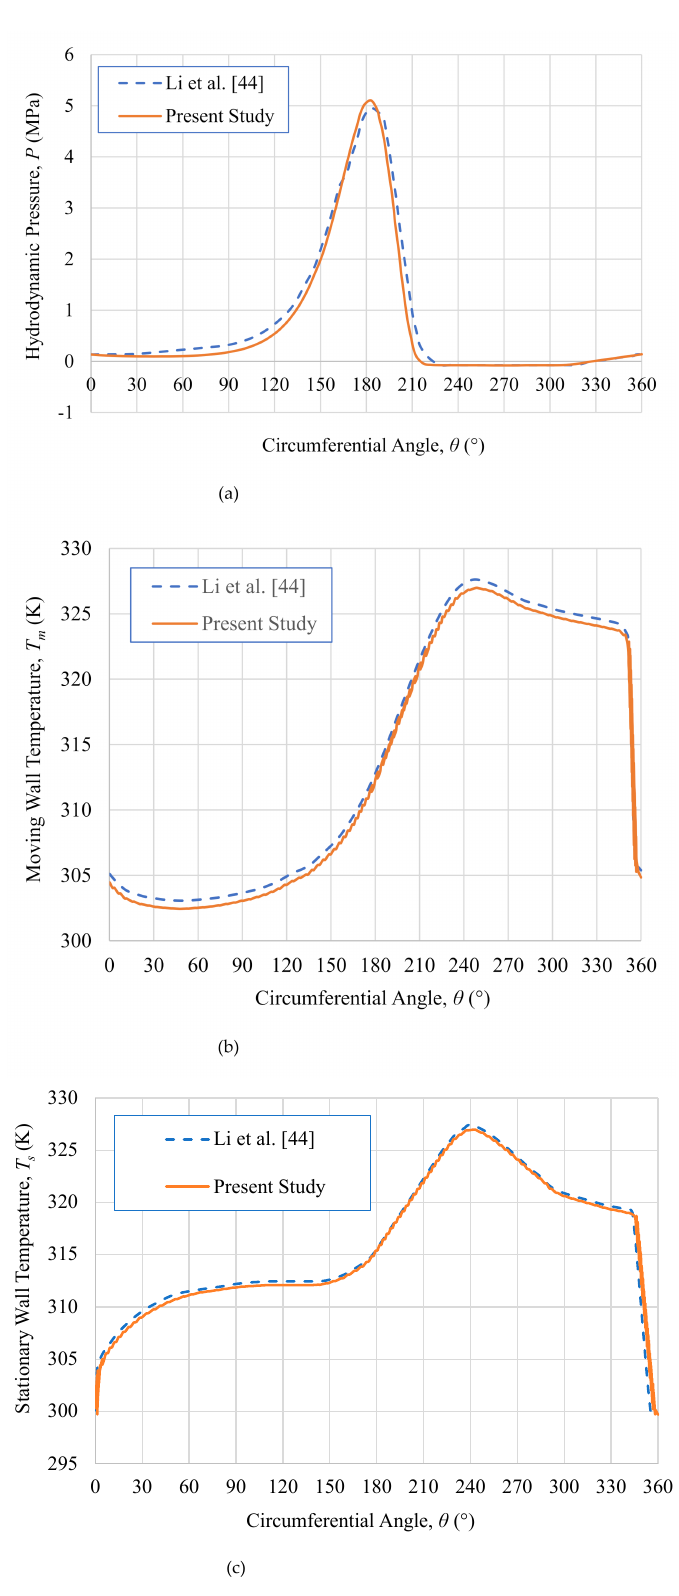
Figure 5. Comparison between the result of the present study and the literature [44] in terms of ( a ) hydrodynamic pressure, ( b ) moving wall temperature, ( c ) stationary wall temperature. The numerical results are evaluated at mid-plane z/ L of 0.5, rotational speed n of 3000 rpm, and eccentricity ratio ε of 0.8.